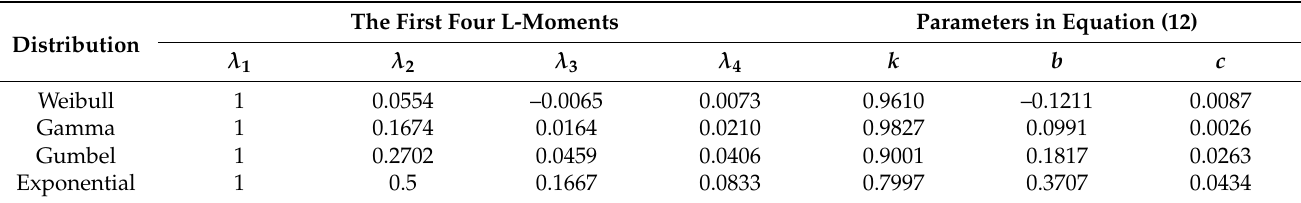
Table 2. Probability distributions and their statistical parameters for Example 1.